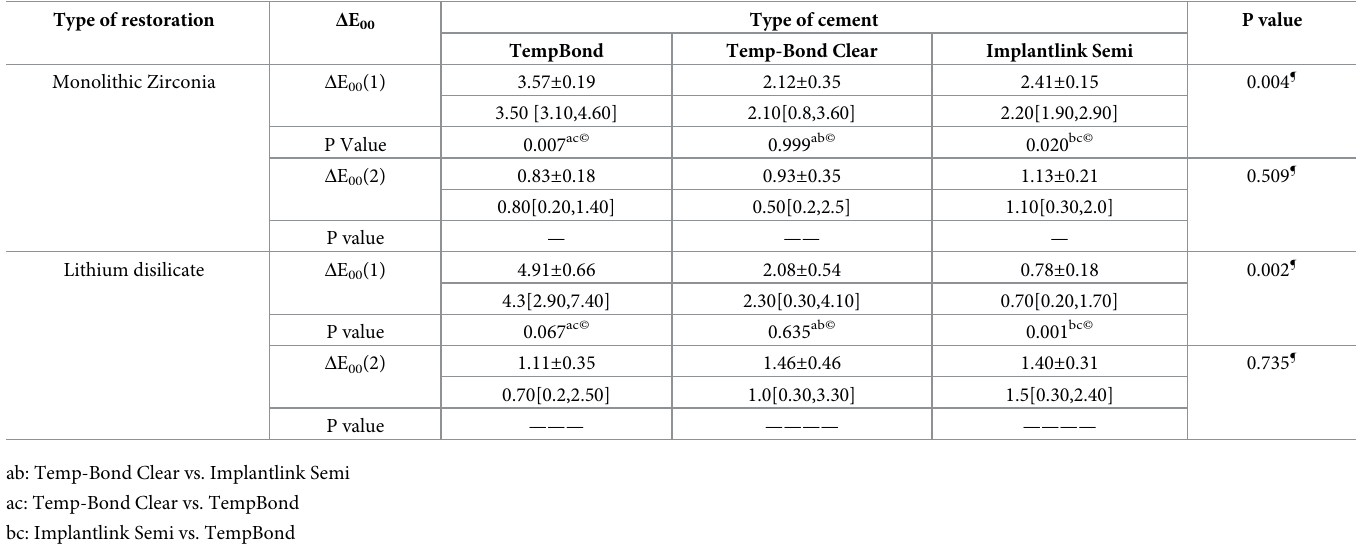
Table 2. Mean ± SD and median [minimum, maximum] of Δ E 00 (1) and Δ E 00 (2) and the results of Kruskal-Wallis H test and Dunn’s post-hoc test comparisons of the cements. Type of restoration